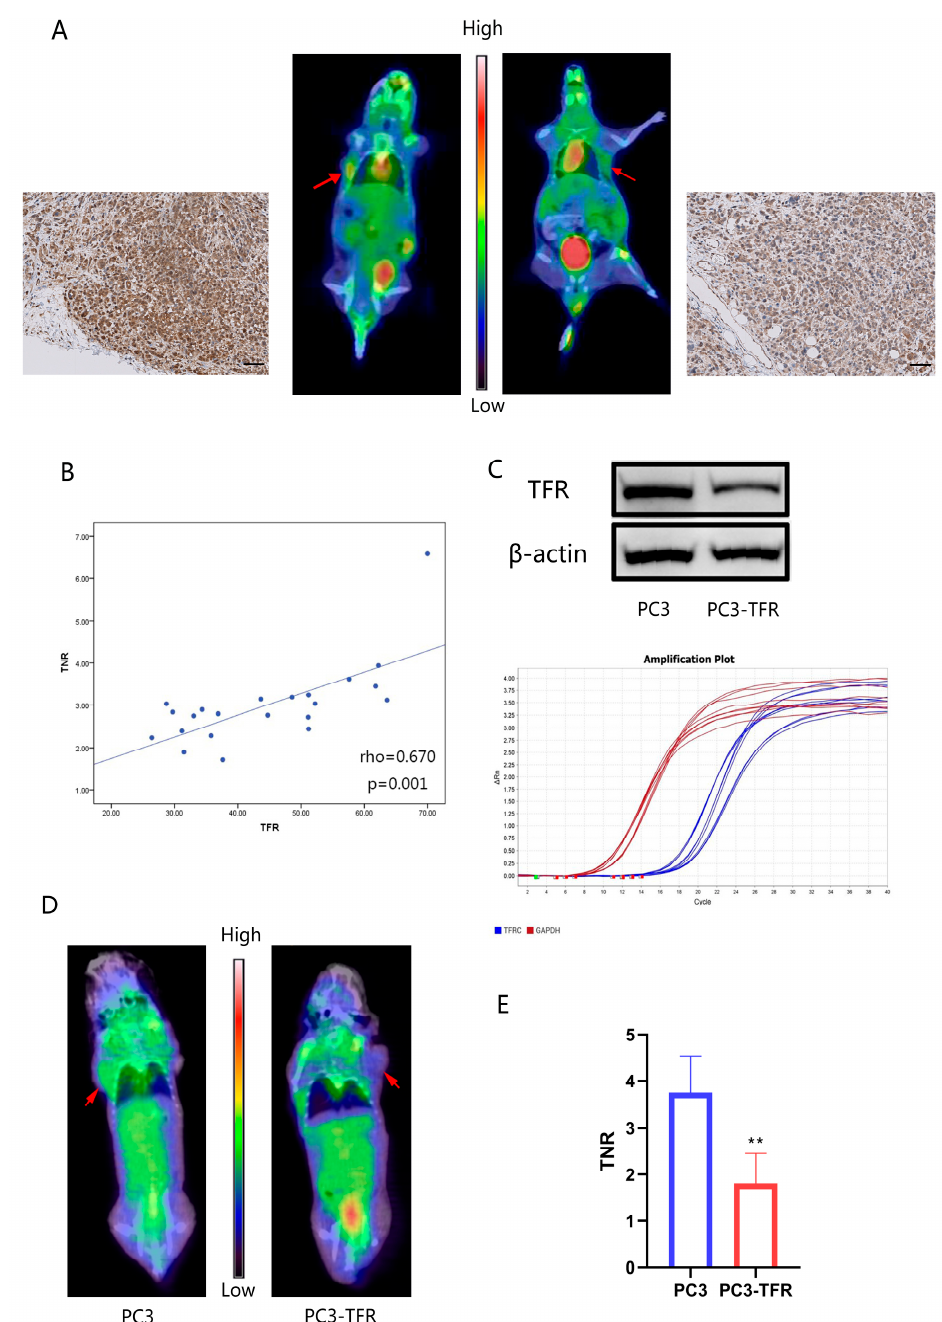
Figure 6. 68 Ga-citrate uptake of PC3 xenograft tumors is correlated with TFR expression. ( A ) 68 Ga- citrate PET/CT images and TFR immunohistochemistry staining of two nude mice with PC3 xenograft tumors. Scale bars: 100 μ m. ( B ) Scatter plot/correlation between TFR expression and TNR of PC3 xenograft tumors. Trend lines and Spearman’s rho correlation coefficient are shown. ( C ) Western blot and qPCR analyses of TFR expression in stably transfected PC3 cell lines. The uncropped immunoblot images can be found in Figure S1. The IntDen of western blot bands can be found in Table S1. ( D , E ) 68 Ga-citrate PET/CT images of nude mice with PC3/stably transfected PC3 cell xenograft tumors. ** p <